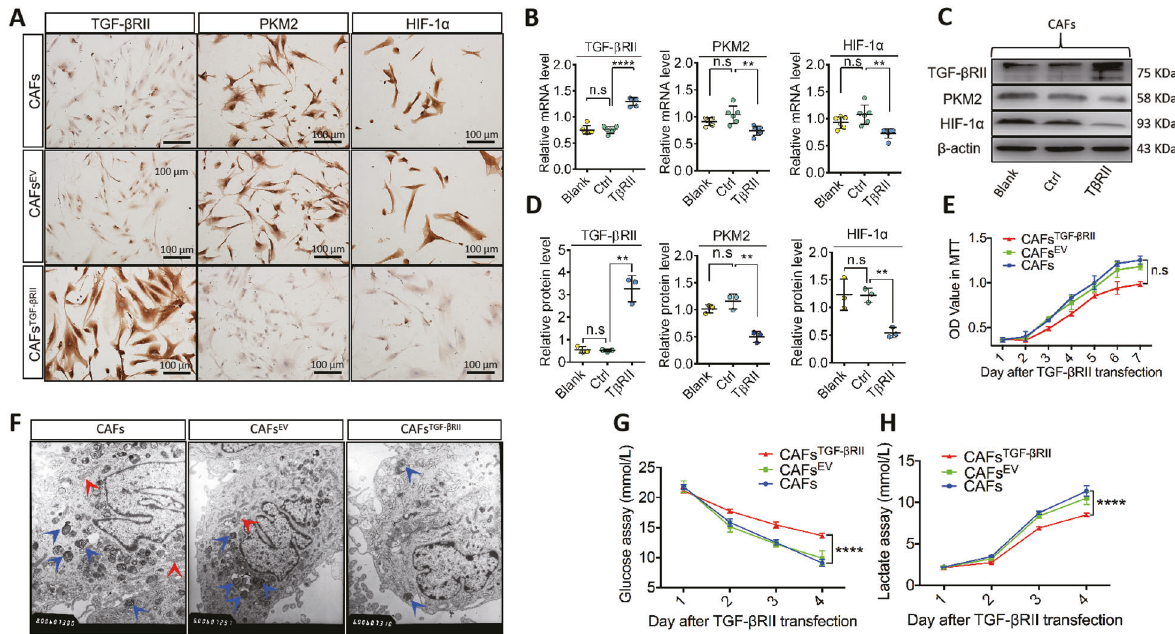
Fig. 2 Overexpressed TGF- β RII inhibited the glycolysis in CAFs and suppressed tumor growth. A By immunocyte chemistry staining, TGF- β RII overexpressed in the intervened CAFs, mainly located in the cellular membrane and cytoplasm, while PKM2 and HIF-1 α were weakly positive in the controls. B – D Immunoblot showed a reduction of PKM2 and HIF-1 α when TGF- β RII was augmented in CAFs. Quanti fi cation of TGF- β RII, PKM2, and HIF-1 α mRNA or protein levels in CAFs with a signi fi cant statistical difference among the groups. E There was no signi fi cant statistic between the CAFs with overexpressed TGF- β RII and the controls by MTT assay. F Abundant autophagosomes and mitochondria were observed in the controls while less in the CAFs with overexpressed TGF- β RII under the electron microscope (blue arrows: autophagosomes; red arrows: mitochondria). G Compared to controls, by glucose assay, upregulated TGF- β RII attenuated the glucose uptake in the CAFs. H Less production of lactic acid was detected in the experimental CAFs than the controls with a signi fi cant statistical difference. Relative mRNA or protein expression level was quanti fi ed after normalization to β -actin. Scale bar = 100 μ m. n ≥ 3; error bars, mean ± SD; n.s. not signi fi cant, ** P < 0.01, *** P < 0.001, **** P < 0.0001; t lactate secretion by inhibiting the glycolysis regulators of PKM2 and HIF-1 α . Fewer autophagosomes were observed in CAFs TGF- β RII (Fig. 2F), indicating that mitochondria were less damaged in CAFs TGF- β RII . In this context, mitochondria would prefer aerobic